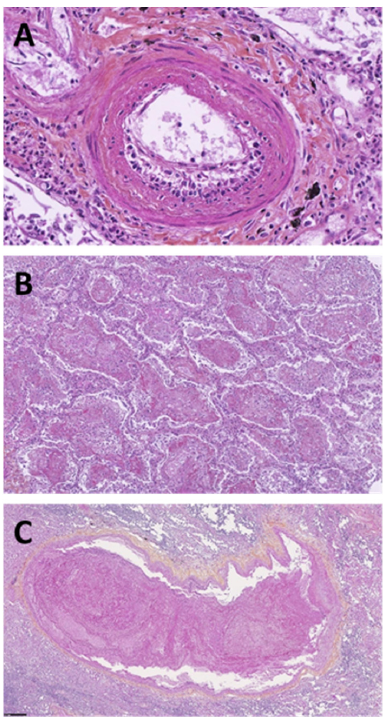
Figure 2. Lung histopathology in fatal COVID-19. ( A ) Hematein–eosin–saffron staining at magnifi- cation ×300; presence of endothelitis: thickening of the intima of a small-caliber arteriole with cell proliferation, intimal edema, and lymphocytic infiltrate. ( B ) Hematein–eosin–saffron staining at magnification ×70; filling of the alveoli with hyaline membranes and thick fibrin; presence of dys- trophic pneumocytes desquamating in the lumens showing acute alveolar damage. ( C ) Hematein– eosin–saffron staining at magnification ×50; fibrin clot.